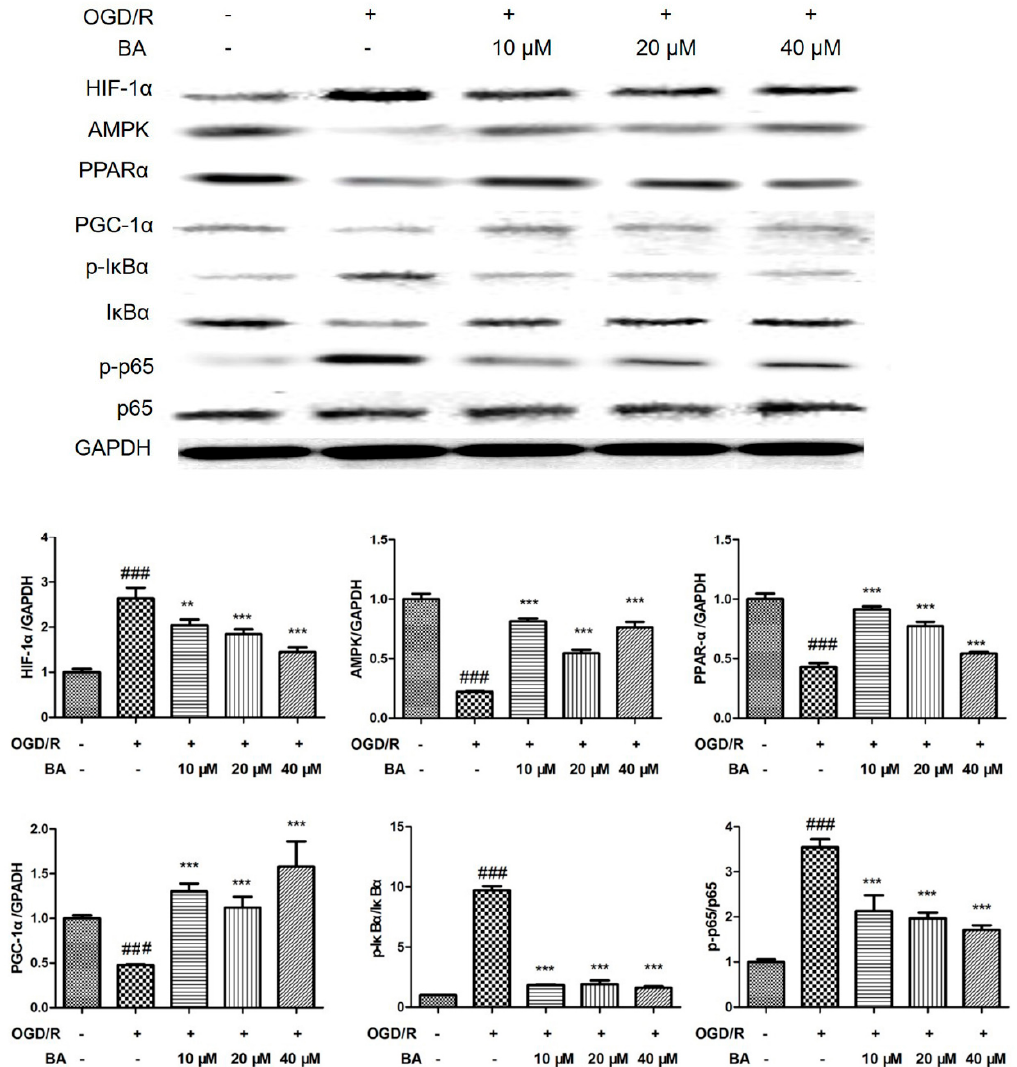
Figure 8. The influence of BA on HIF-1 α , AMPK, PPAR- α , PGC-1 α , I κ B α and NF- κ Bp65 in OGD / R-induced SHSY5Y cells. Compared with control cells (### p < 0.001) and compared with OGD / R cells (** p < 0.01 and *** p < 0.001).